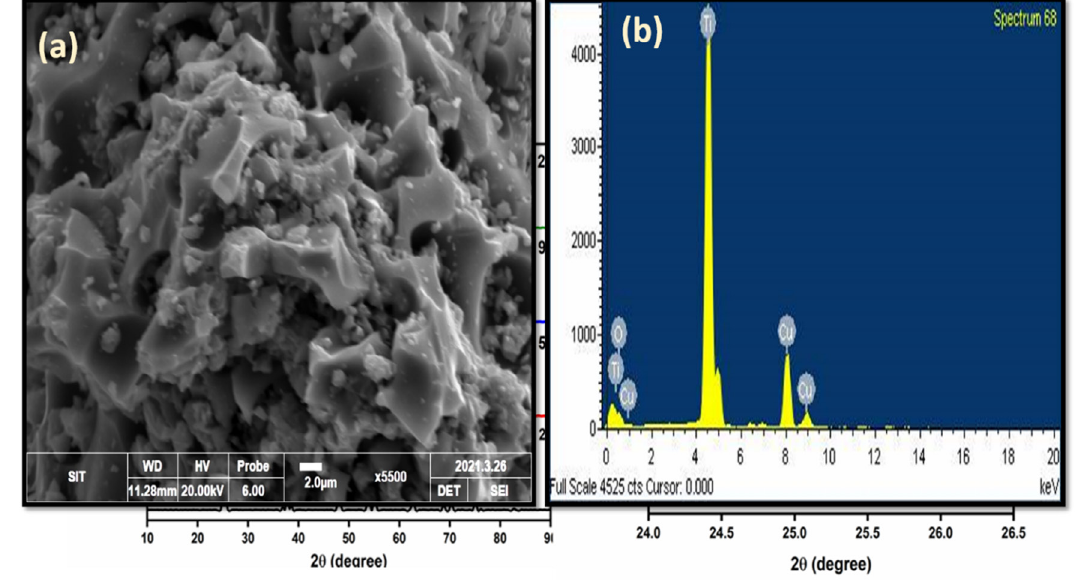
Fig. 2. (a) SEM image of TiO